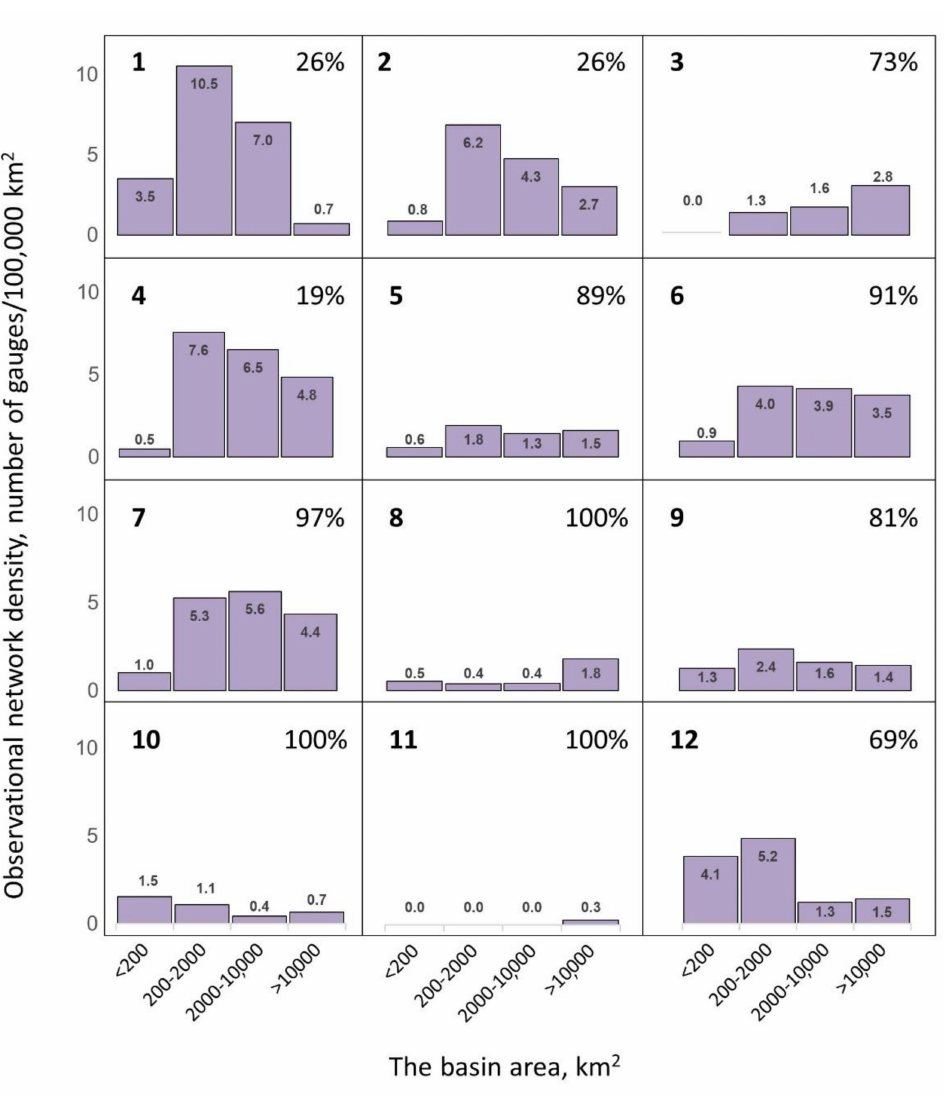
Figure 3. The density of hydrological gauges with streamflow discharge observations is classified by basin area in different DHS (see Tables 1 and 2) with indicated permafrost (%) for DHS